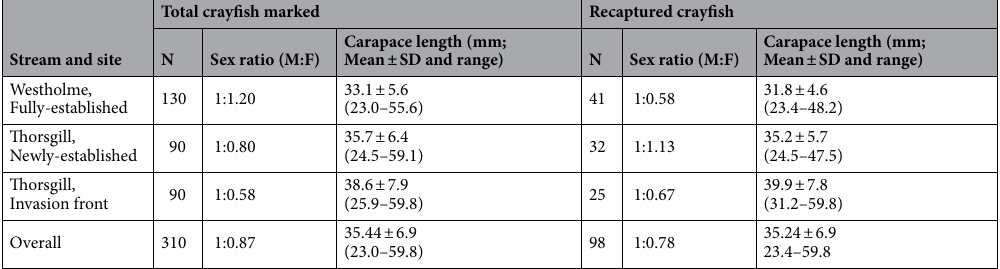
Stream and site